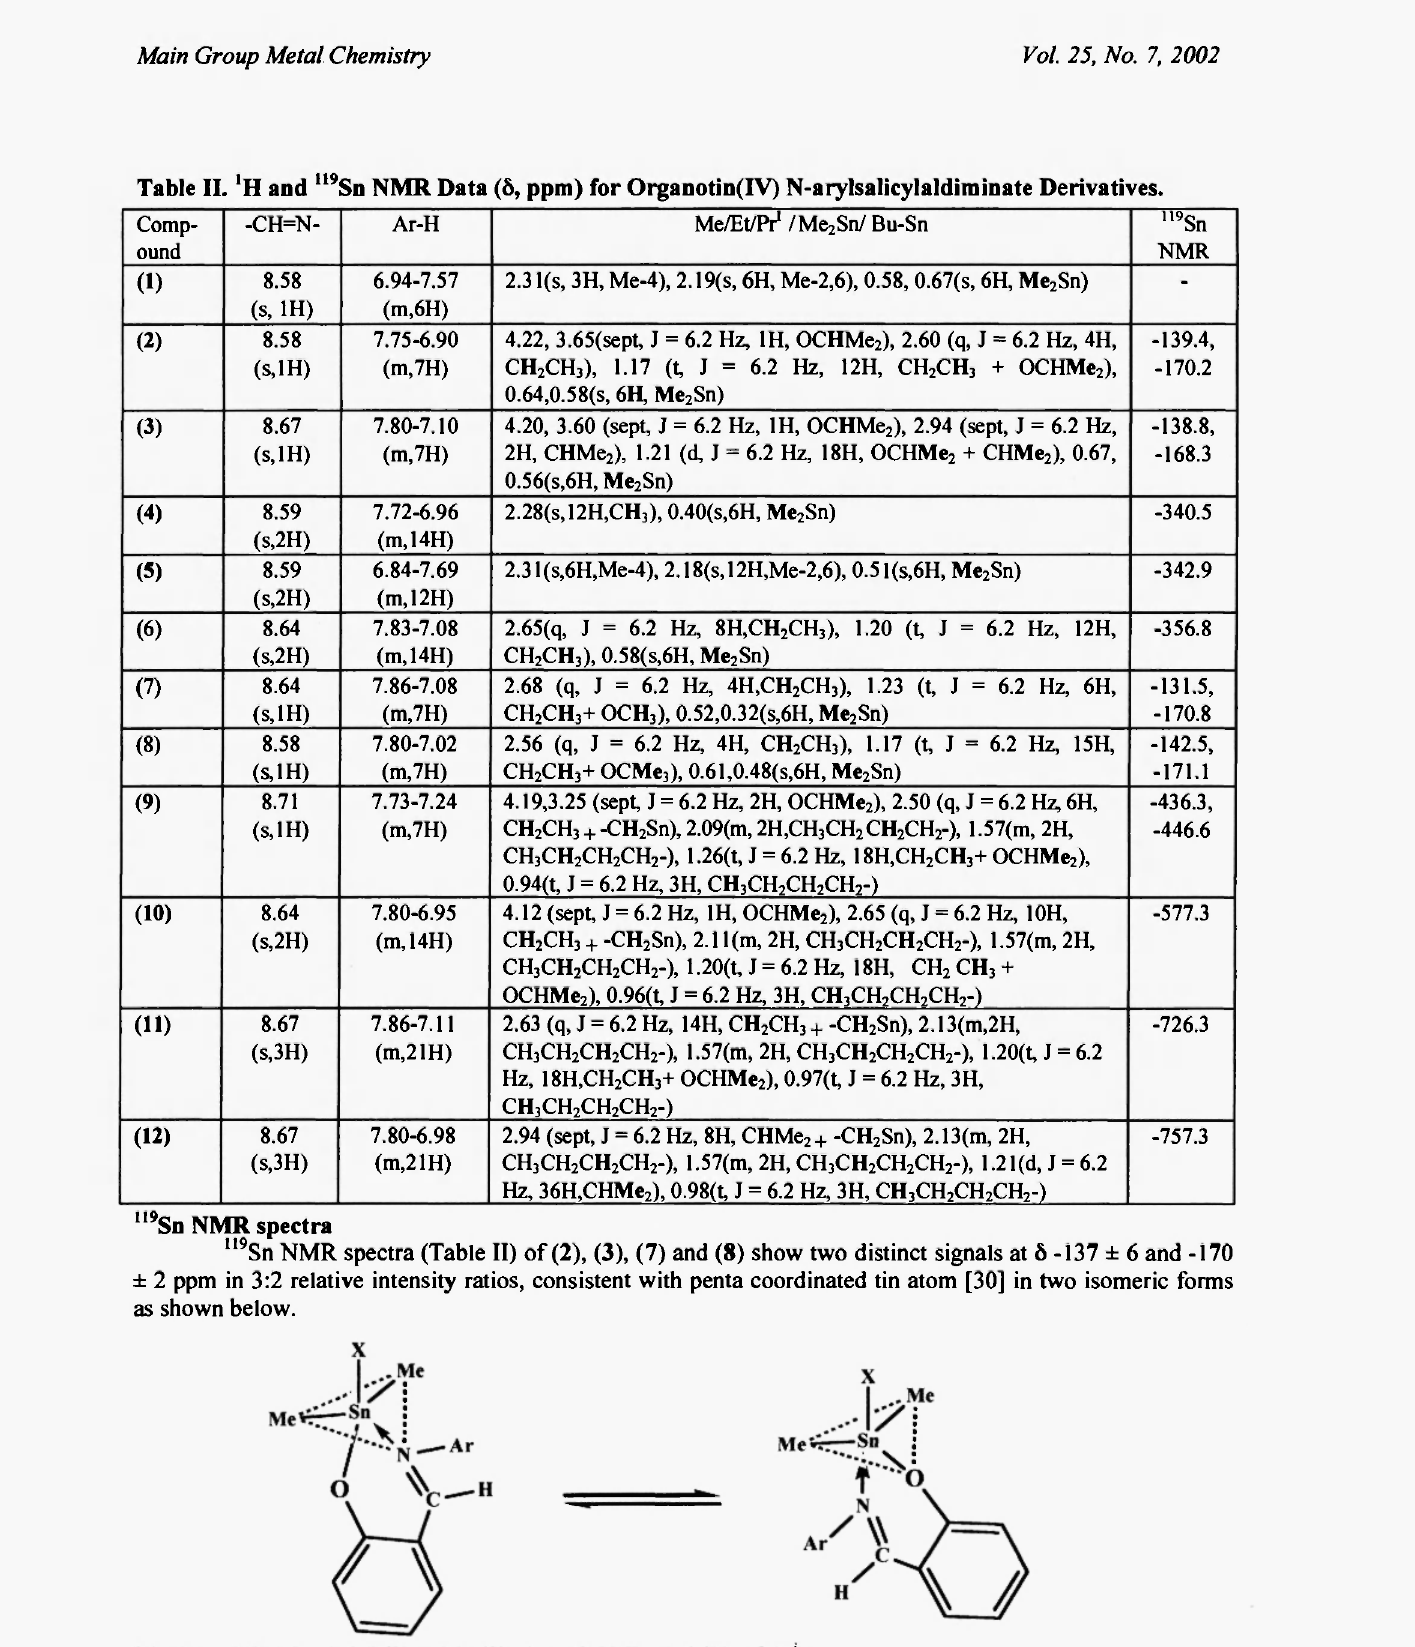
Sn NMR spectra (Table II) of (2), (3), (7) and (8) show two distinct signals at δ -137 ± 6 and -170 ± 2 ppm in 3:2 relative intensity ratios, consistent with penta coordinated tin atom [30] in two isomeric forms as shown